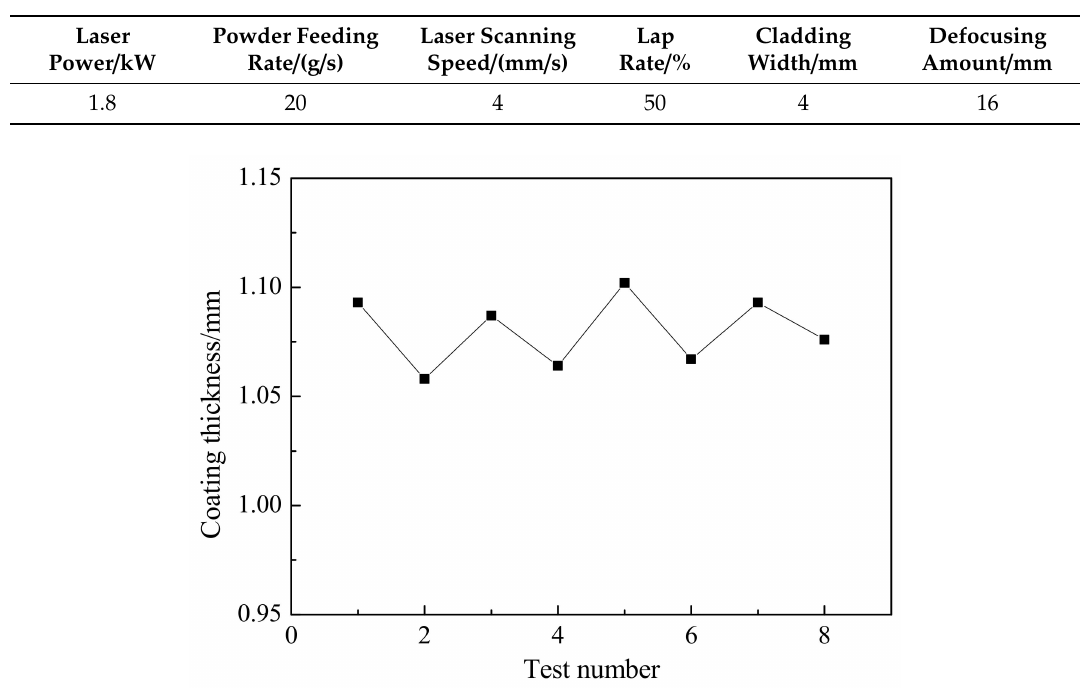
Table 4. The laser cladding process parameters of the mould.